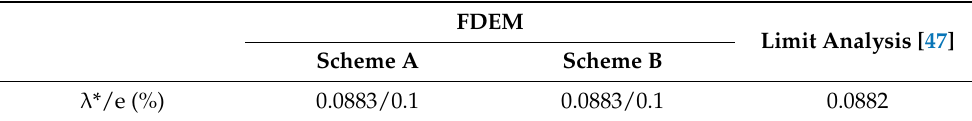
Table 4. Seismic capacity of the multi-span pointed arch structure.